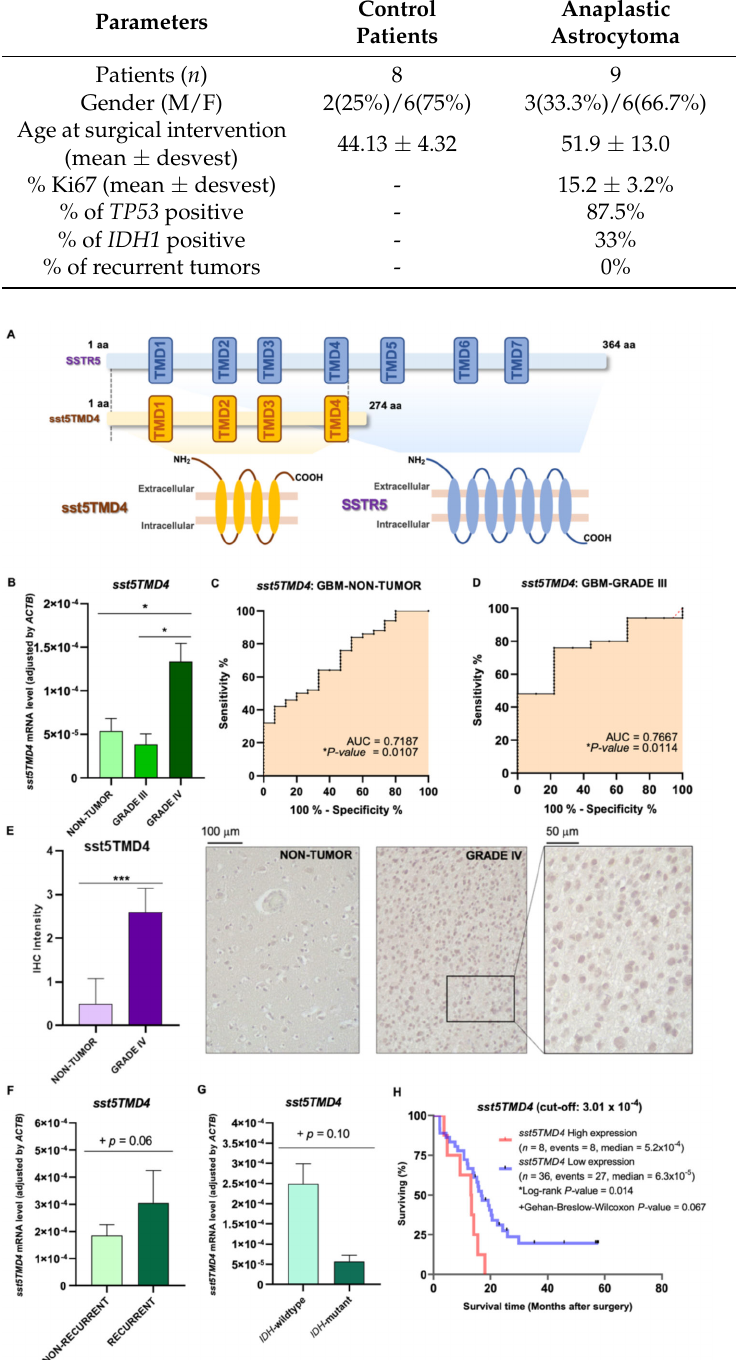
Figure 1. Characterization and clinical relevance of sst5TMD4 in glioblastoma samples. ( A )